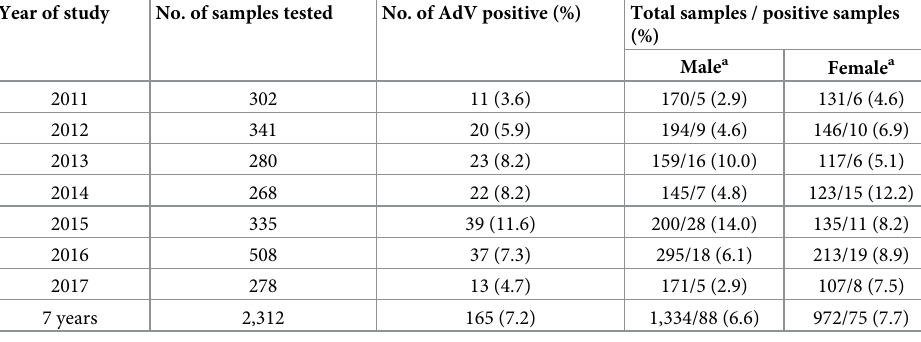
Table 1. Detection rates of HAdV infection in children with acute gastroenteritis in Chiang Mai, Thailand from 2011 to